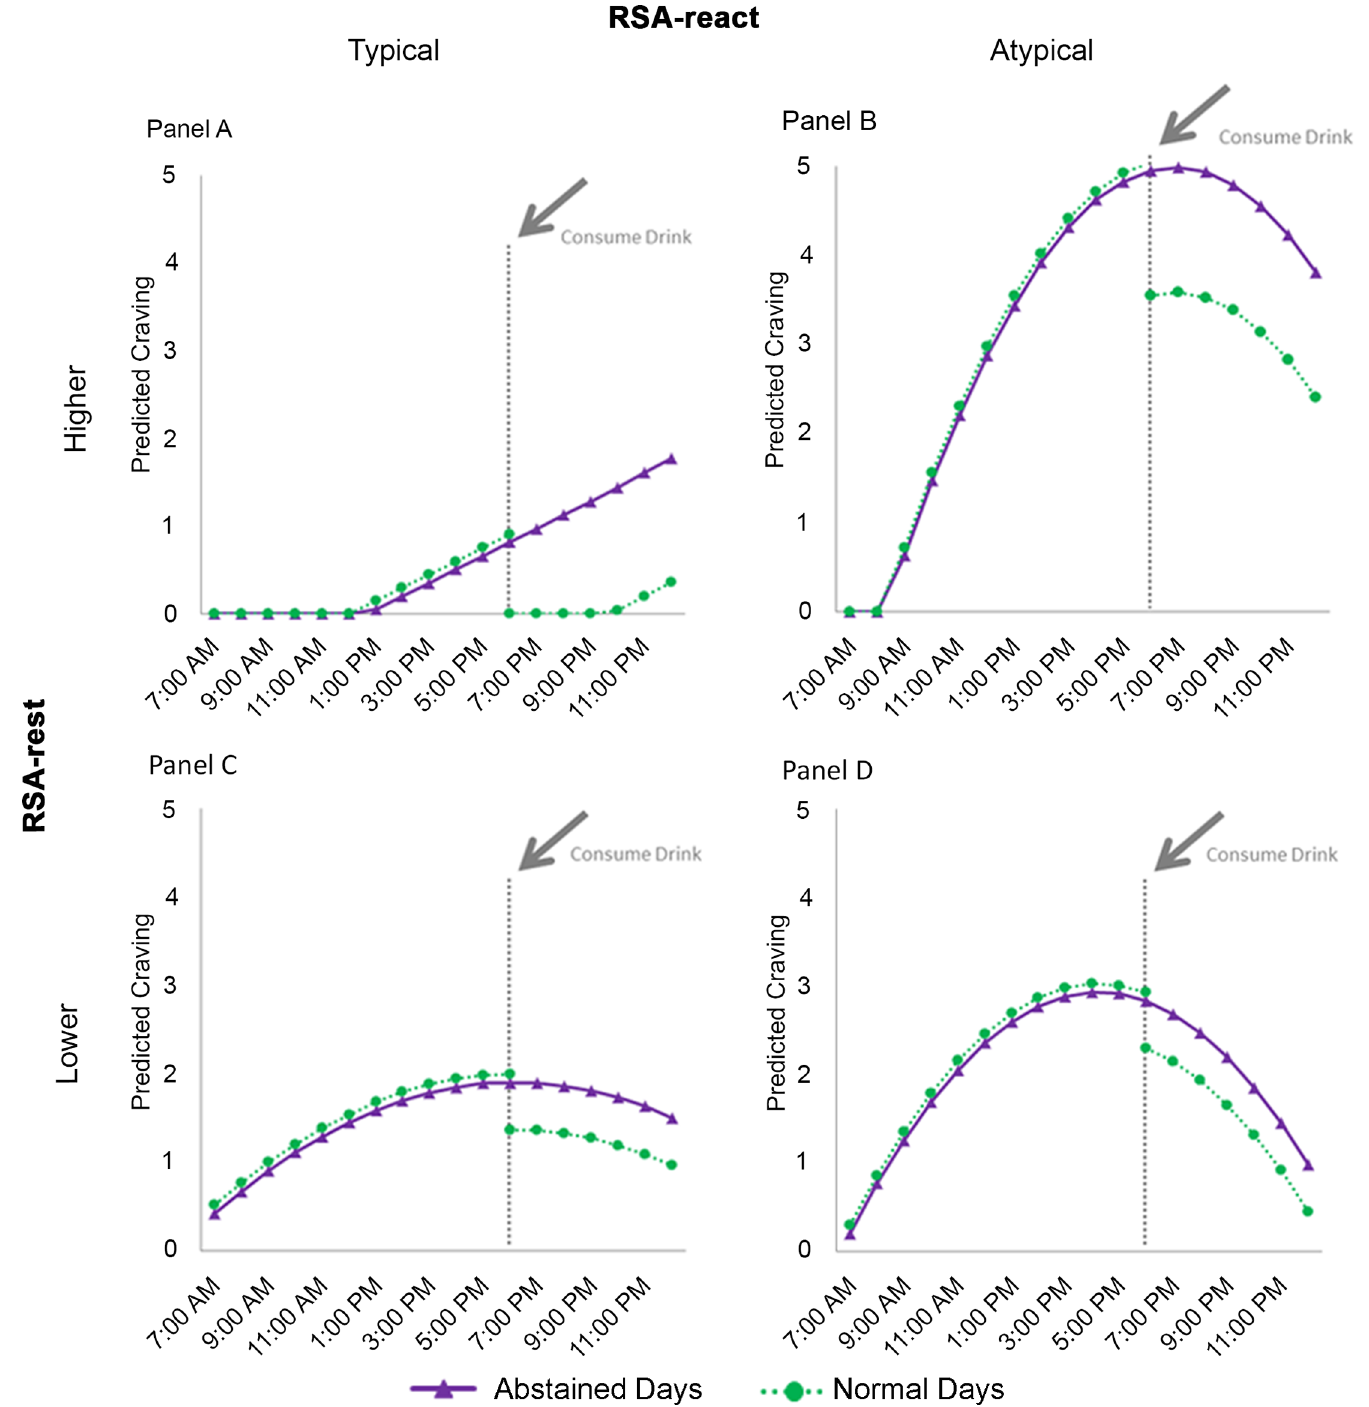
Fig 2. Plot of model-based estimates of craving across the 3-days of abstinence and before and after taking a drink during the 3-day normal period for four hypothetical cases. 1) RSA-rest set at 1 SD above the mean and residualized RSA-react set at 1 SD below than mean (higher RSA-rest/typical residualized RSA-react; Panel A); 2) RSA-rest set at 1 SD above the mean and residualized RSA-react set at 1 SD above than mean (higher RSA-rest/atypical residualized RSA-react; Panel B); 3) RSA-rest set at 1 SD below the mean and residualized RSA-react set at 1 SD above the mean (lower RSA-rest/typical residualized RSA-react, Panel C); and 4) RSA-rest set at 1 SD below the mean and residualized RSA-react set at 1 SD below than mean (lower RSA-rest/atypical residualized RSA-react; Panel D).